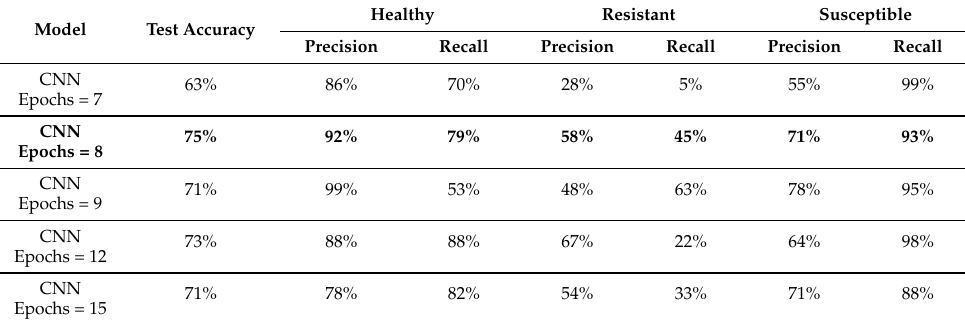
Table 1. Results for models trained on low-resolution